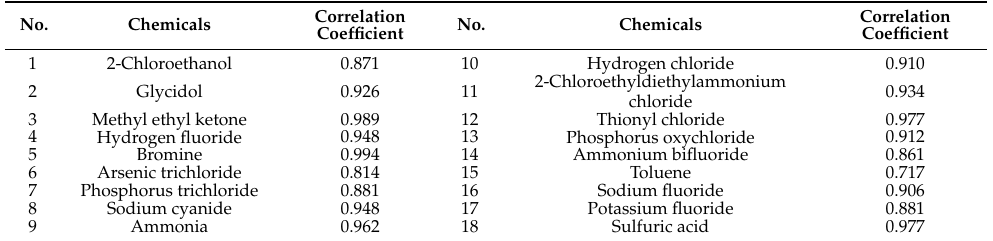
Table 2. The correlation coefficients between each 18 spectral samples and characteristic spectral